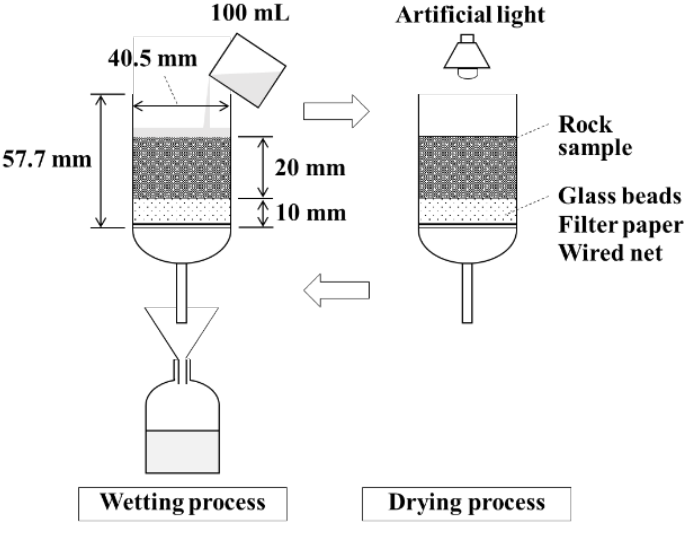
Figure 1. Schematic of the leaching test.